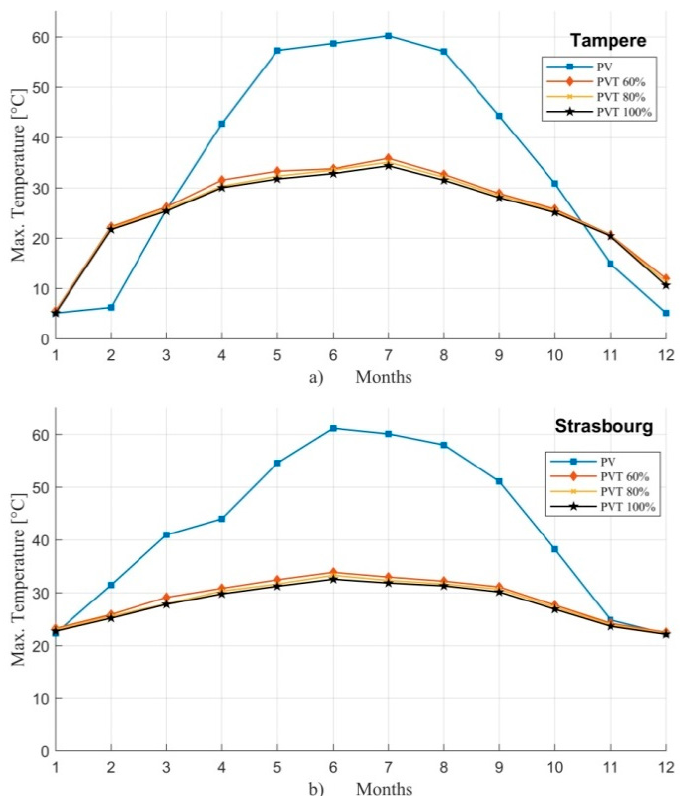
Figure 11. Monthly maximum PV cell operating temperatures of the PV panel and PVT collector with different packing factors in ( a ) Tampere and ( b ) Strasbourg. Energies 2020 , 13 , x FOR PEER REVIEW 18 of 27